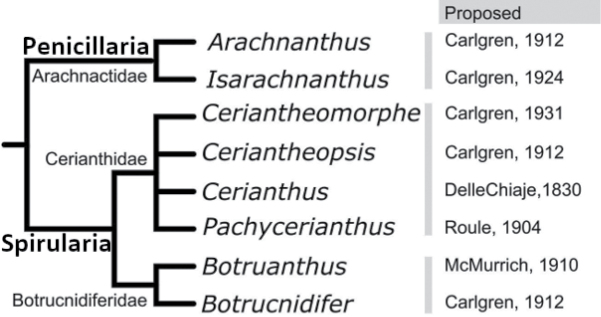
Classification of Ceriantharia (adapted from Stampar et al. 2016a).